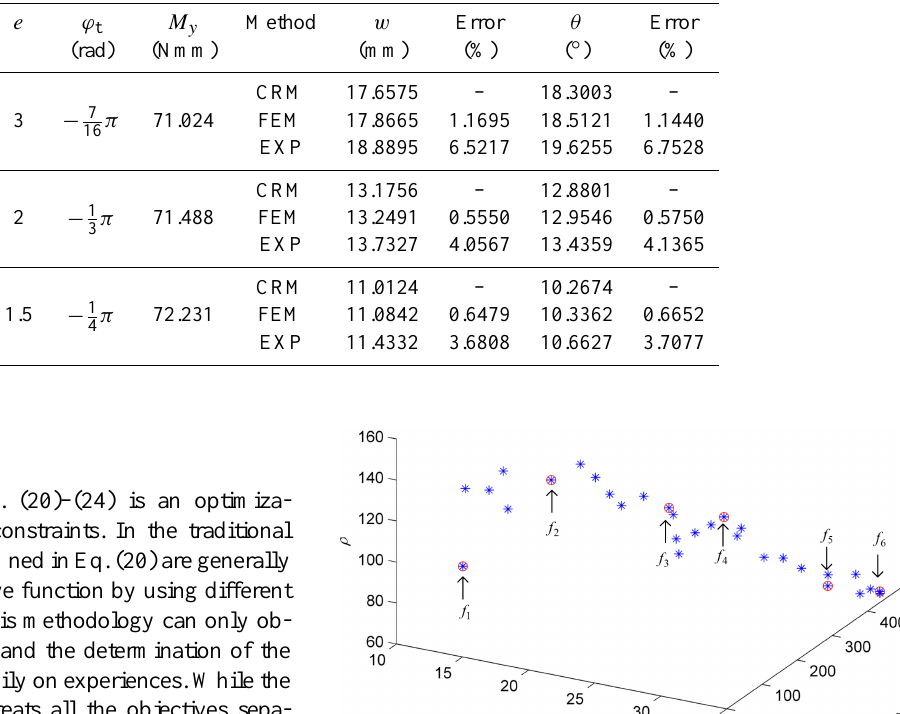
Table 1. Displacements calculated by CRM, AFE and EXP.